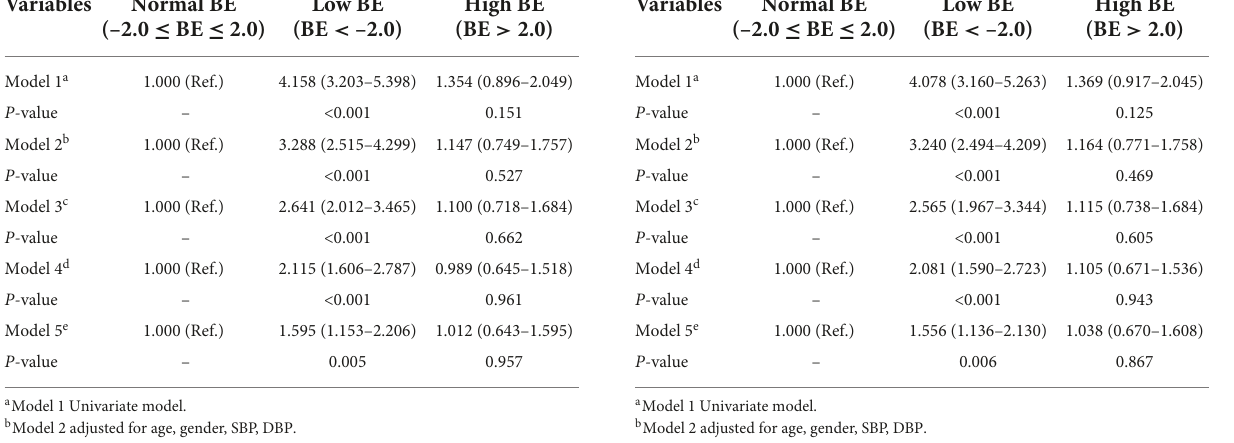
TABLE 3 Cox proportional hazard models for 90-day all-cause